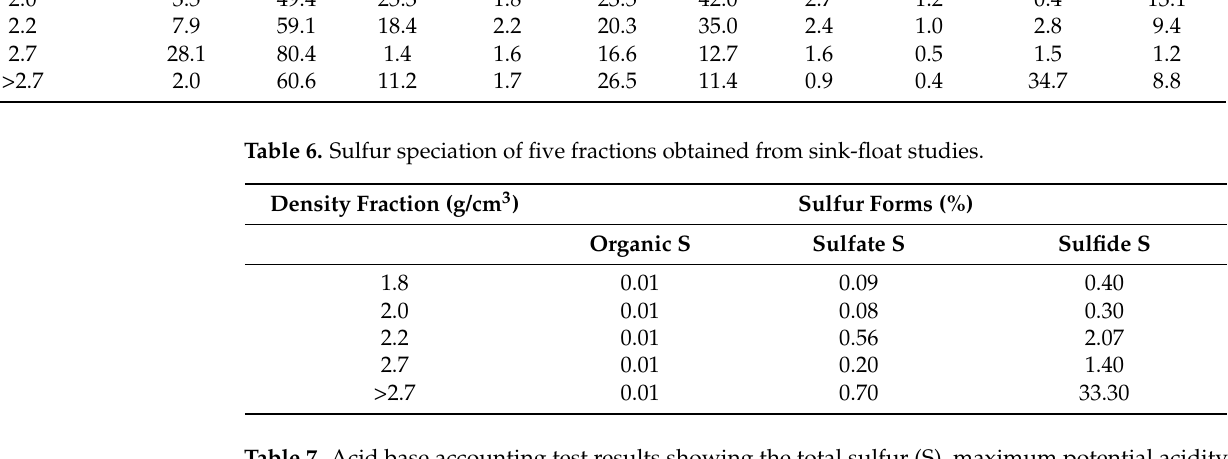
Table 7. Acid base accounting test results showing the total sulfur (S), maximum potential acidity (MPA), acid neutralizing capacity (ANC), and net acid producing potential (NAPP) of five fractions obtained from densimetric